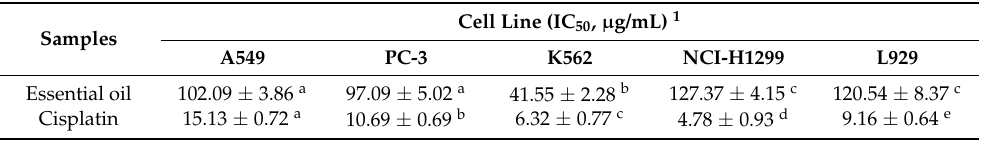
Table 5. Cytotoxic activity of A. galanga flower essential